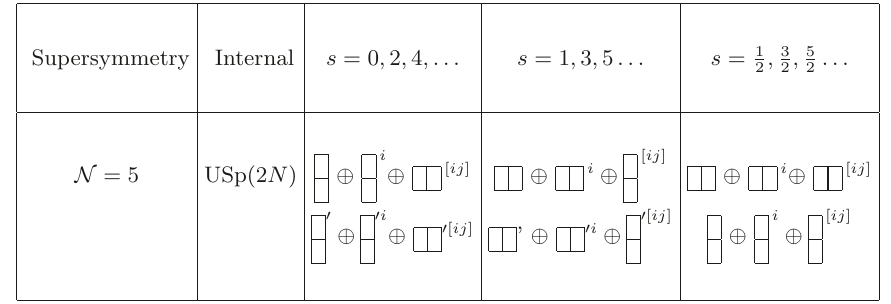
= 5 ABJ theory in the limit (1.3). The N